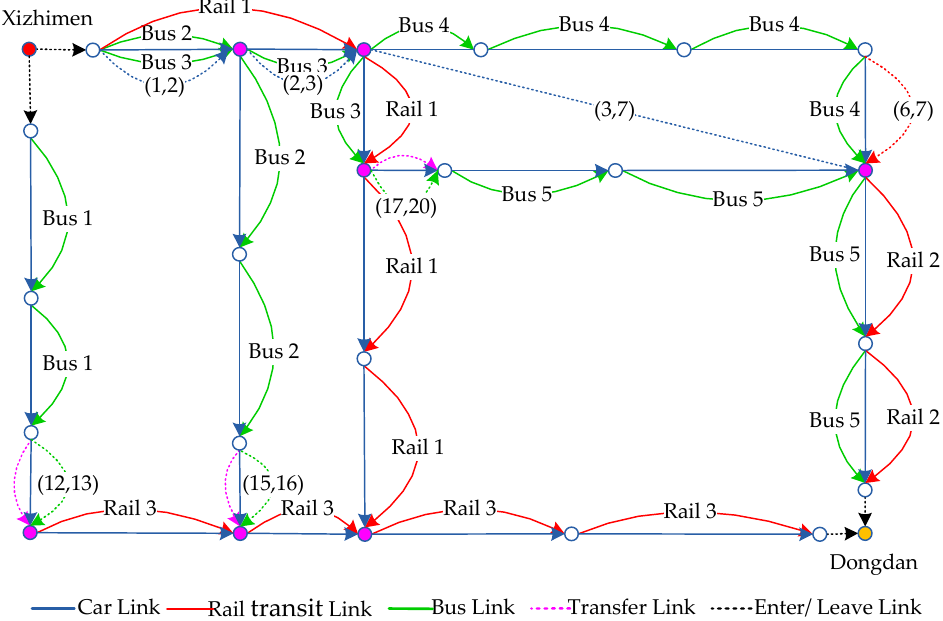
Figure 15. Multimodal transportation network from Xizhimen to Dongdan.